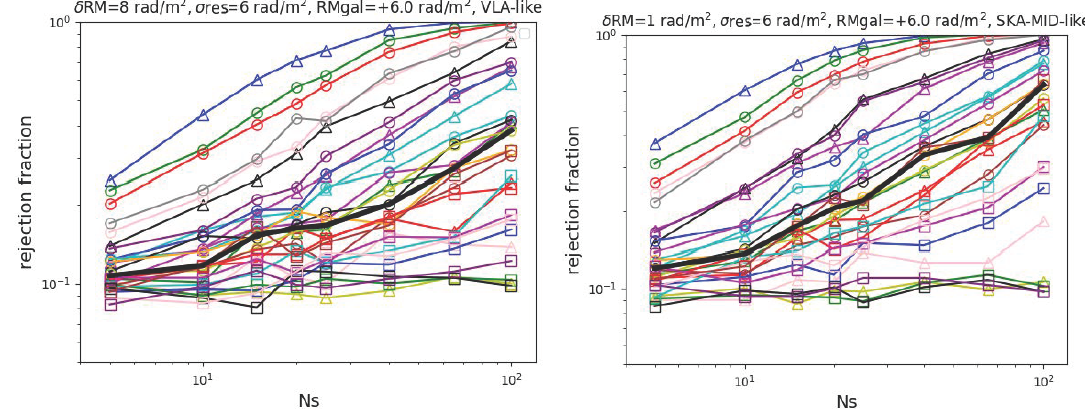
Figure 8. Same as Figure 3 (lower panels) for the primordial seeding scenario with B init = 1